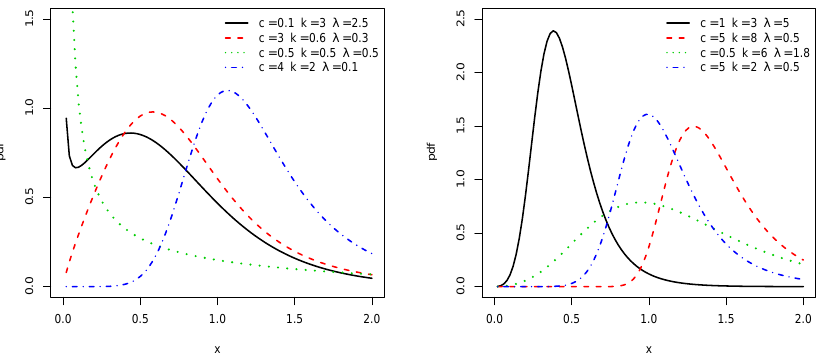
Figure 1. Density function of NMBIII distribution.